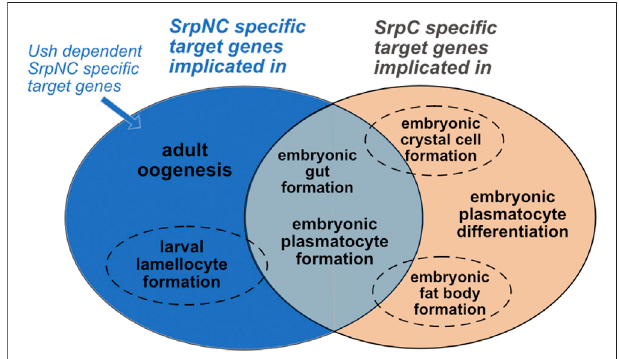
FIGURE 7 | SrpC and SrpNC regulate speci fi c, partially overlapping and completely overlapping repertoires. Gut and plasmatocyte formation are similarly regulated by both SrpNC and SrpC (grey). Crystal cell and fat body developmentrequireSrpCandareonlypartiallycompensatedbySrpNC (dotted circle, orange). In contrast, hematopoietic homeostasis (re fl ected by lamellocyte formation inhibition) depends mainly on SrpNC and might only slightly be dependent on SrpC (dotted circle, blue). Both isoforms have speci fi c functions: SrpNC controls oogenesis (blue) and SrpC at least partially controls plasmatocyte differentiation (as shown by Pxn dependence on SrpC expression in plasmatocytes, orange). All currently identi fi ed SrpNC mediated functions are dependent of its interaction with